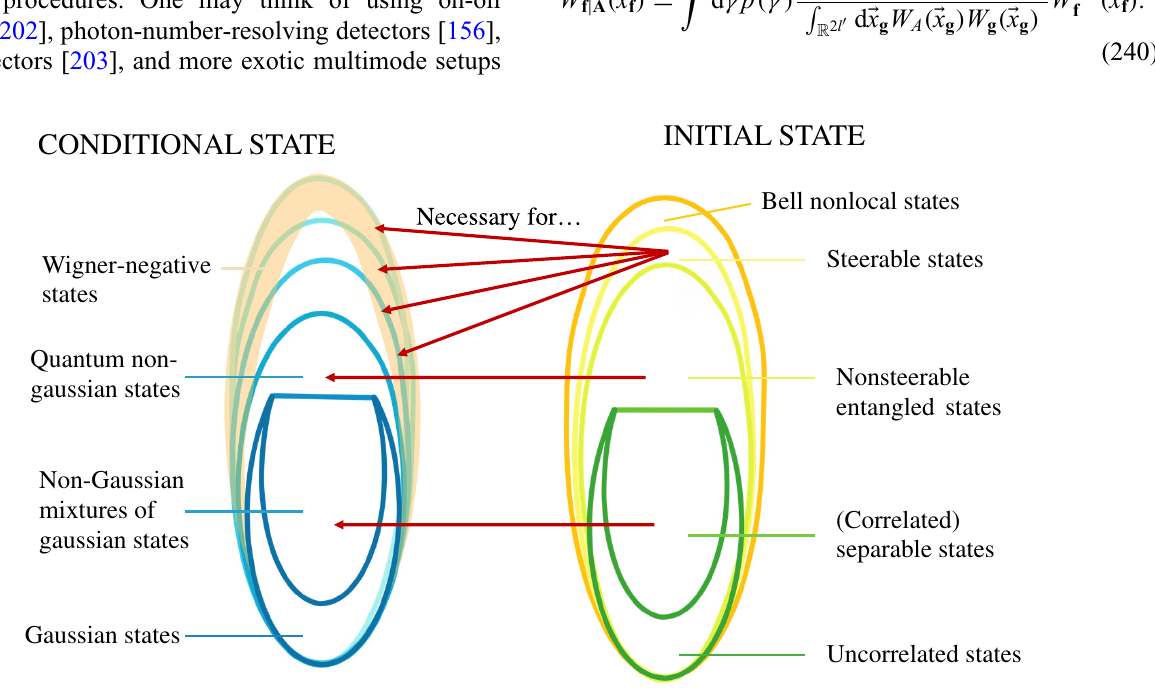
FIG. 5. Different types of quantum correlations are required to be present in the initial Gaussian state W ( (cid:13) x ) to create conditional states W f | A ( (cid:13) x f ) , as described in Eq. (190), that belong to a certain class. We thus show how the typical hierarchy of quantum correlations (right) can be connected to the structure of the CV state space that was introduced previously in Fig. 1. Throughout Sec. B, we prove that these different types of quantum correlations are necessary resources to achieve different types of